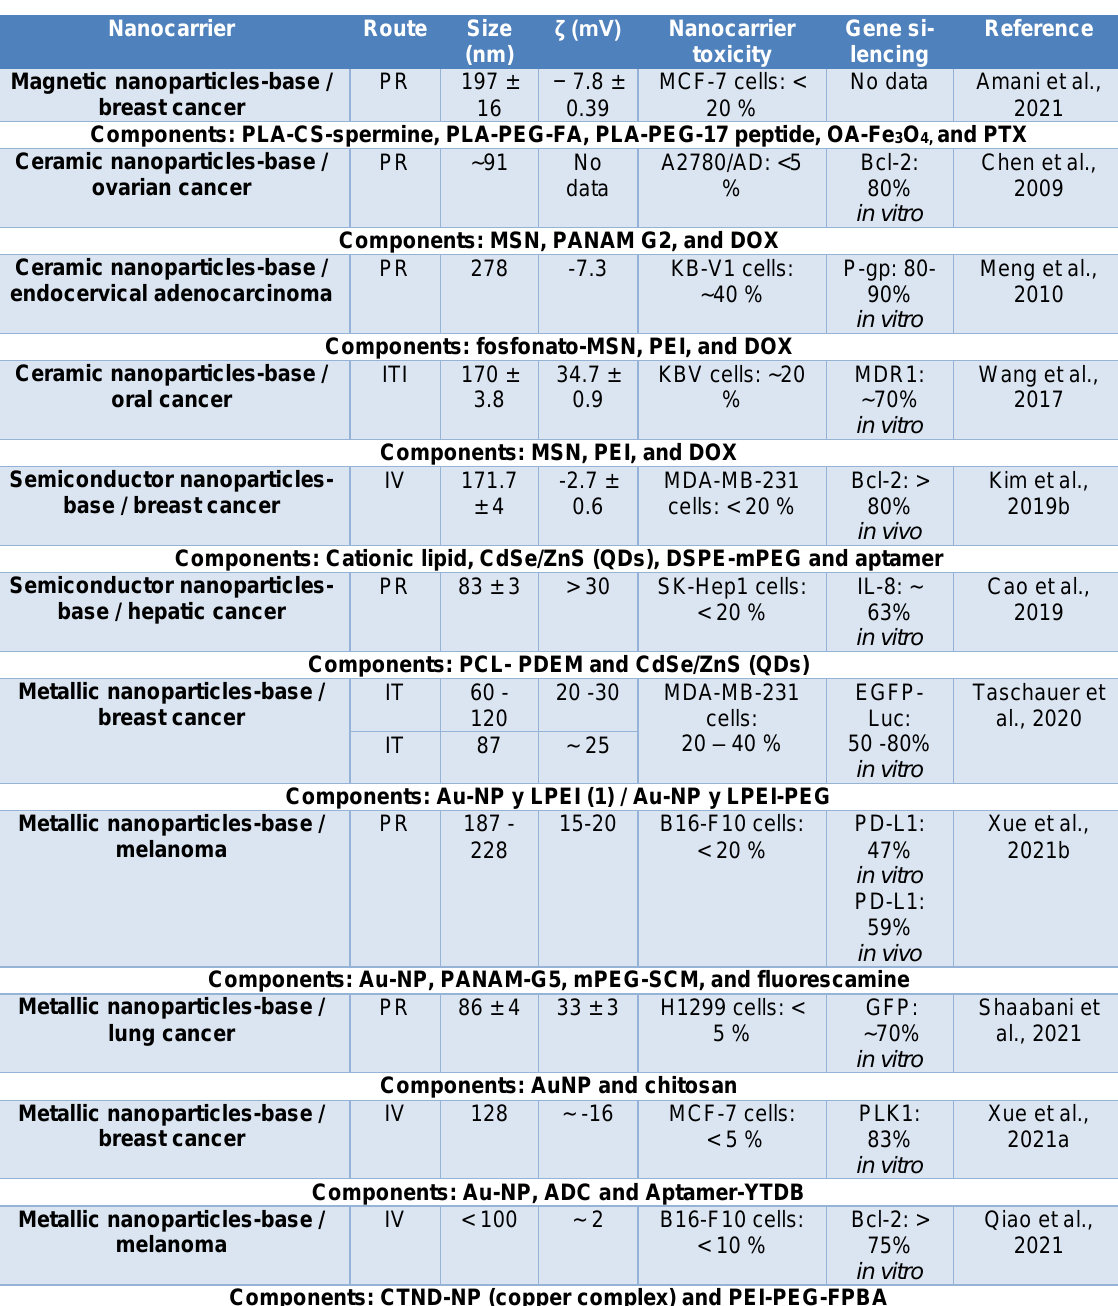
Table 4: Nanocarriers composed of inorganic